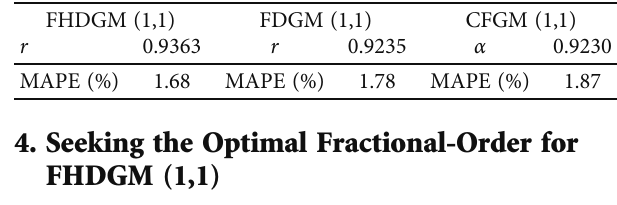
Figure 2: The structural chart for forecasting renewable energy consumption. Table 5: Optimal parameters of the three models showing renewable energy consumption in the Asia Paci fi c